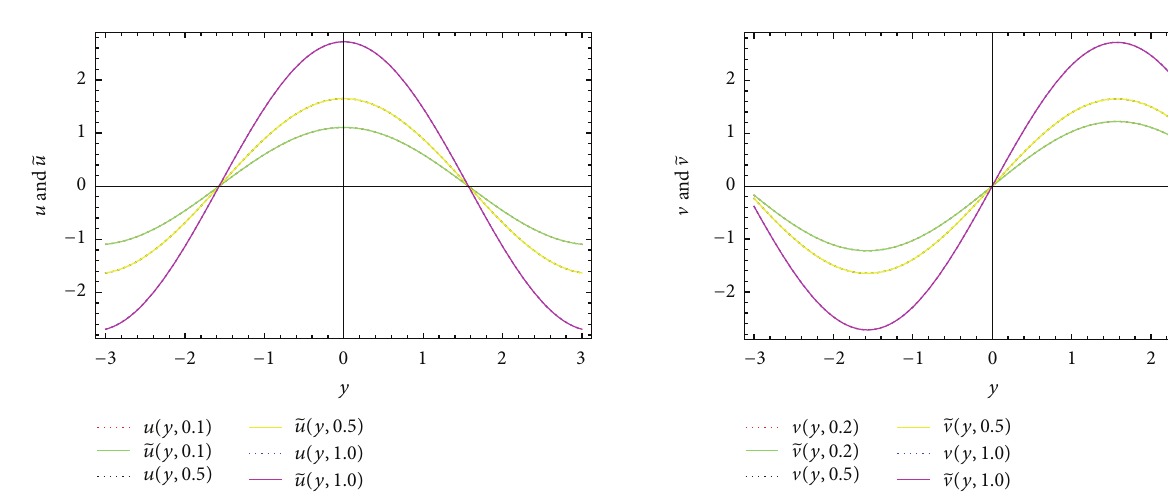
Figure 15: The approximate ̃𝑢 and the exact 𝑢 solutions for different values of 𝑡 = 0.1 , 0.5, and 1.0 of problem (55), where 𝑁 = 10 and 𝛼 = 𝛽 = 1/2 in the interval [0,1] .